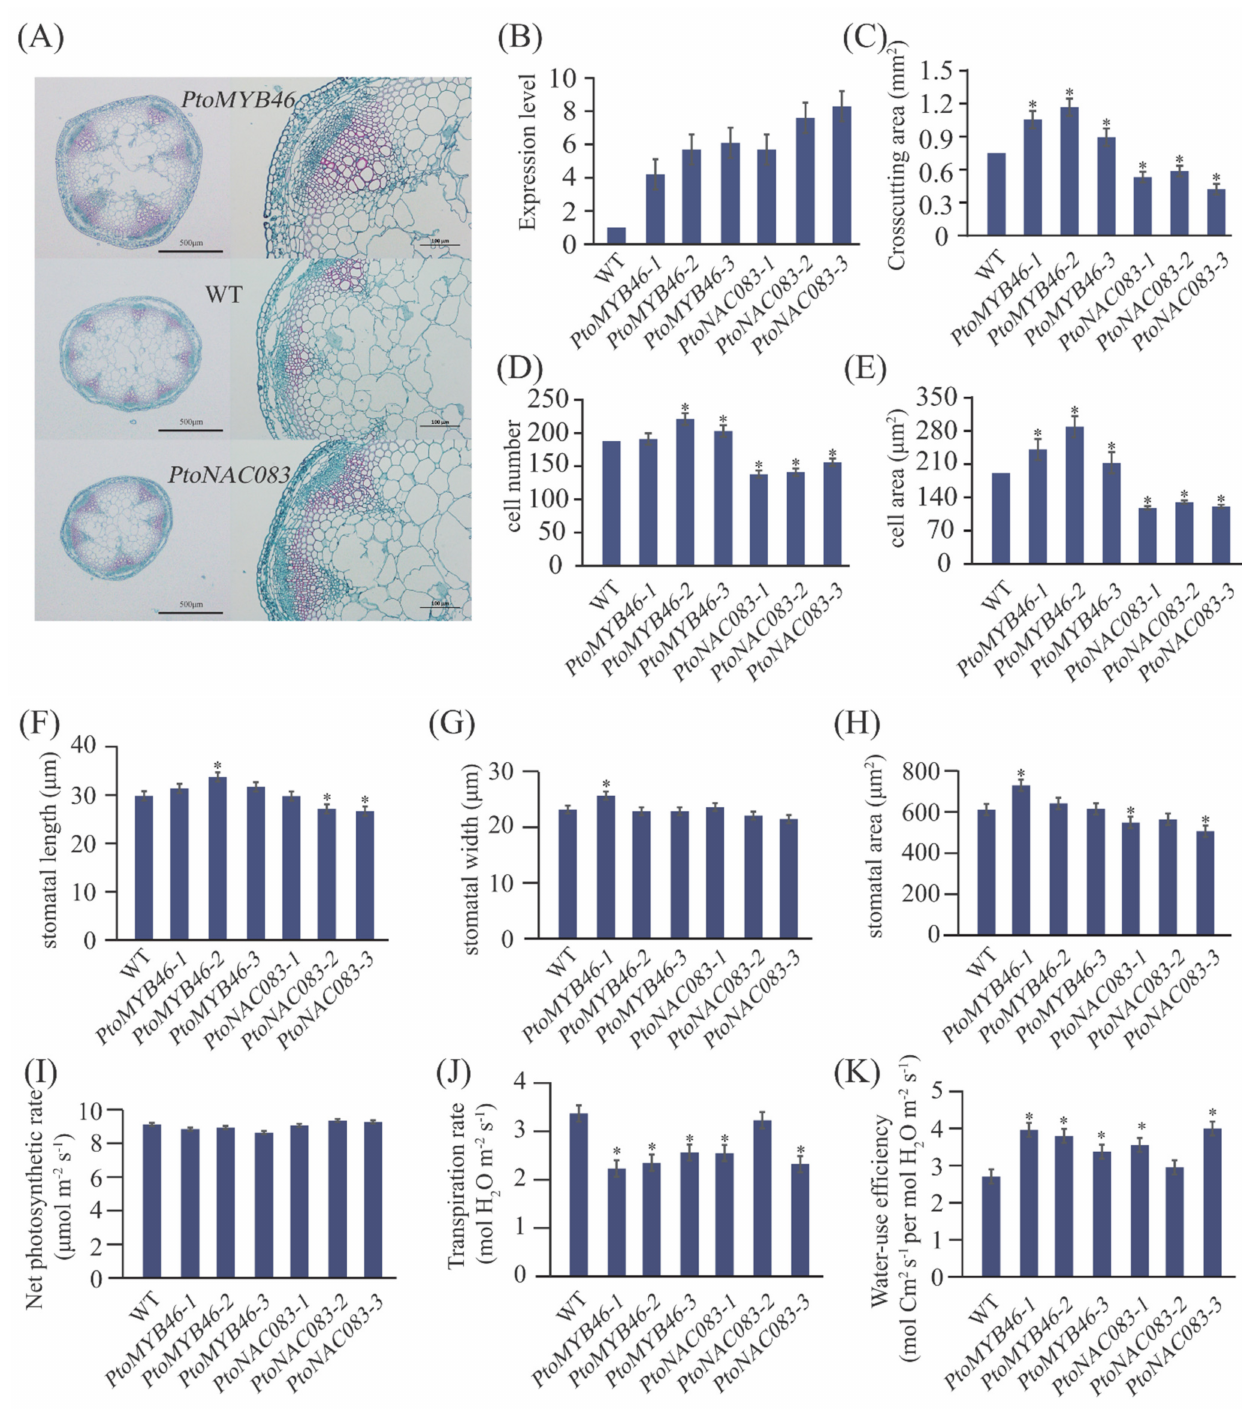
Figure 5. Characterization of PtoNAC083 , PtoMYB46 , and WT plants. ( A ) Overall morphology and stem characteriza- tion of PtoNAC083-1 , PtoMYB46-1 , and WT plants. ( B ) Relative expression levels of WT, PtoNAC083 and PtoMYB46 . ( C – E ) Basal stem cross-sectional area, epidermal cell number, and epidermal cell area of PtoNAC083 , PtoMYB46 , and WT plants. ( F – H ) Statistics of stomatal in in the hypocotyls. Stomatal length ( F ), Stomatal length ( G ) and Stomatal area ( H ). ( I – K ) Net photosynthetic rate ( I ), transpiration rate ( J ), and instantaneous leaf water-use efficiency (WUE) ( K ). *, p <